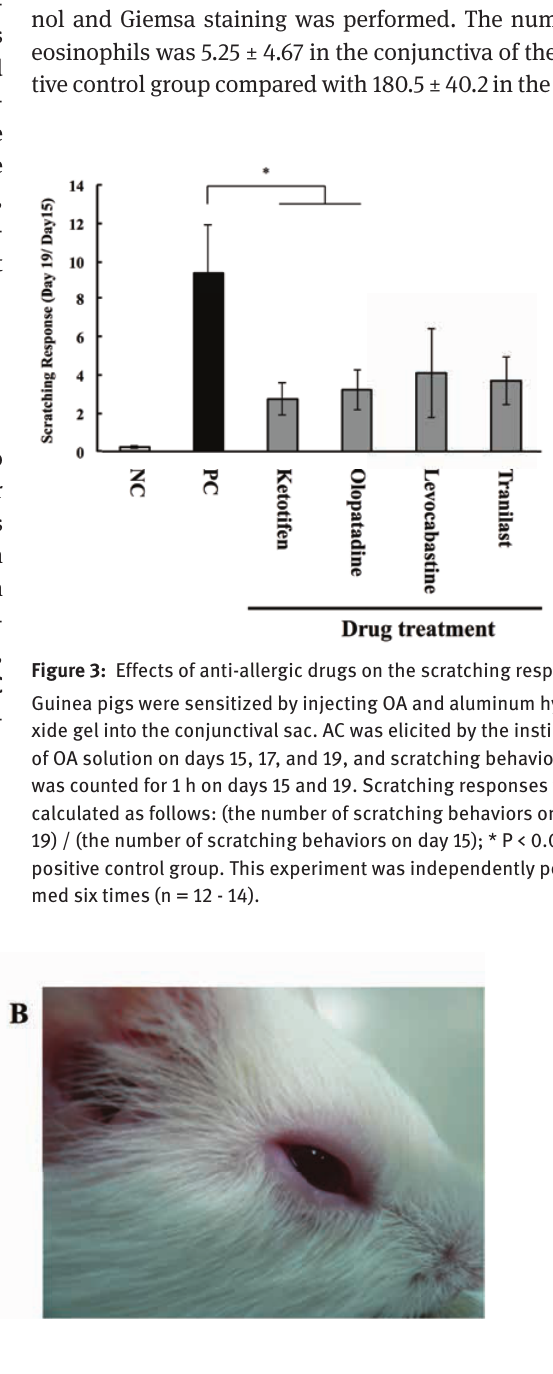
Figure 2: Clinical symptoms in OA-induced AC animals.